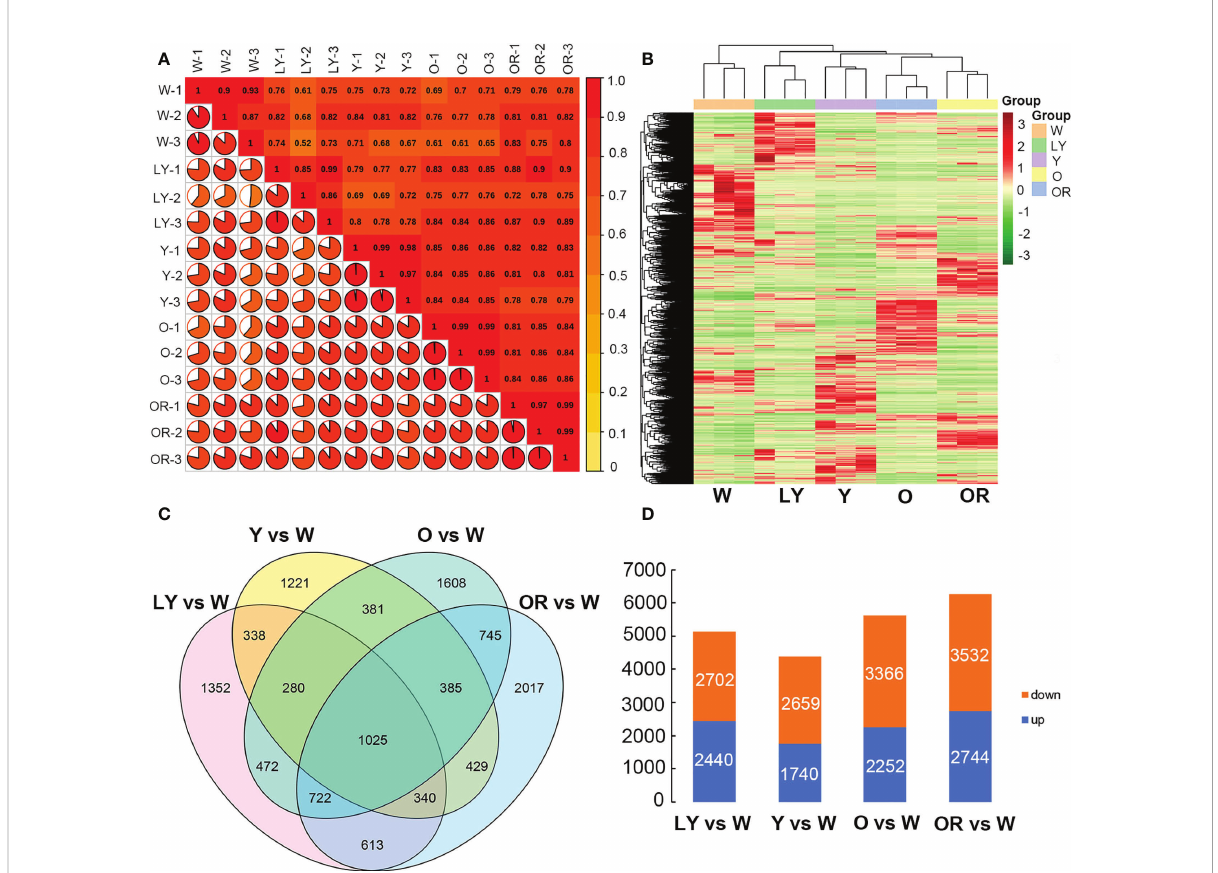
FIGURE 2 Gene expression pro fi ling of fi ve samples. (A) Correlation coef fi cients between gene expression data sets from three biological duplicates. (B) Heatmap illustrates expression pattern of differentially expressed genes in fi ve sweetpotato fl eshes. (C) Venn diagram showing differentially expressed genes between each pairwise comparison. (D) Bar graphs showing the upregulated and downregulated genes in four pairwise